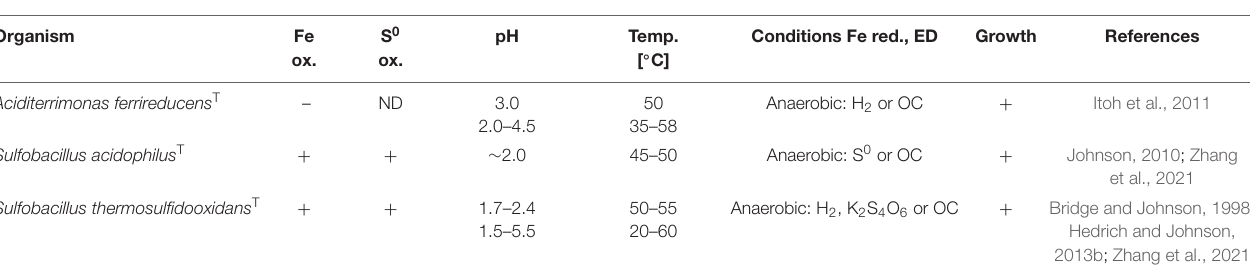
TABLE 4 | Ferric iron-reducing extreme acidophilic mixotrophic bacteria.